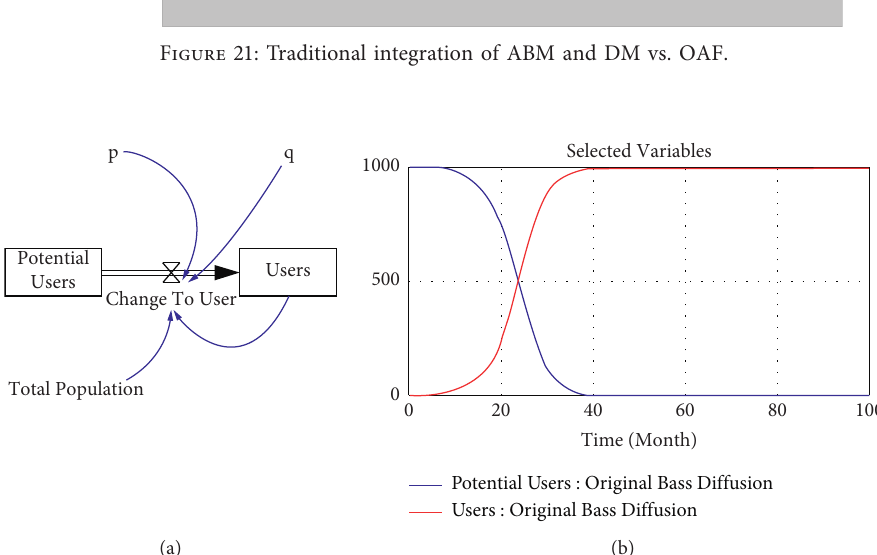
Figure 22: (a) Stock-flow diagram for Bass diffusion SD model. (b) Simulation outputs of Bass diffusion SD model.